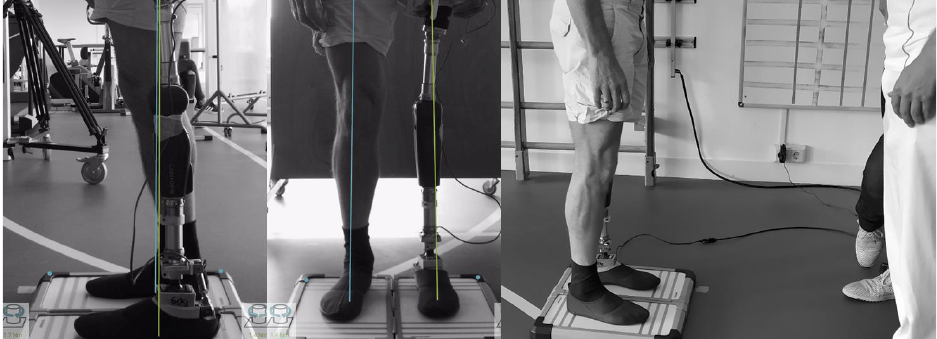
Figure 3. Alignment of the foot prosthesis.